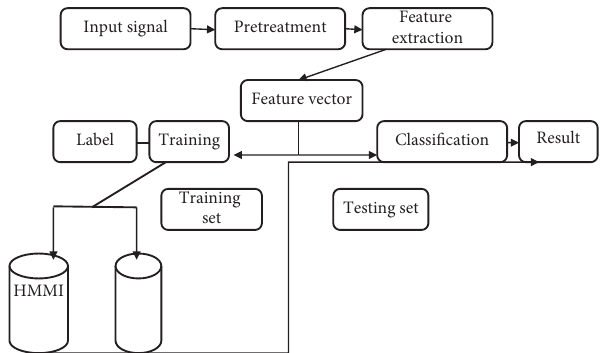
Figure 4: Structure diagram of audio automatic classification system.